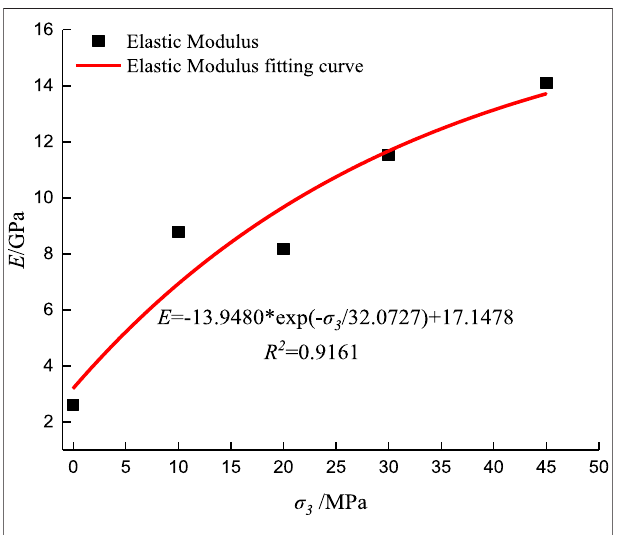
FIGURE 7 | Stress-strain curves of sandstone under triaxial compression at different